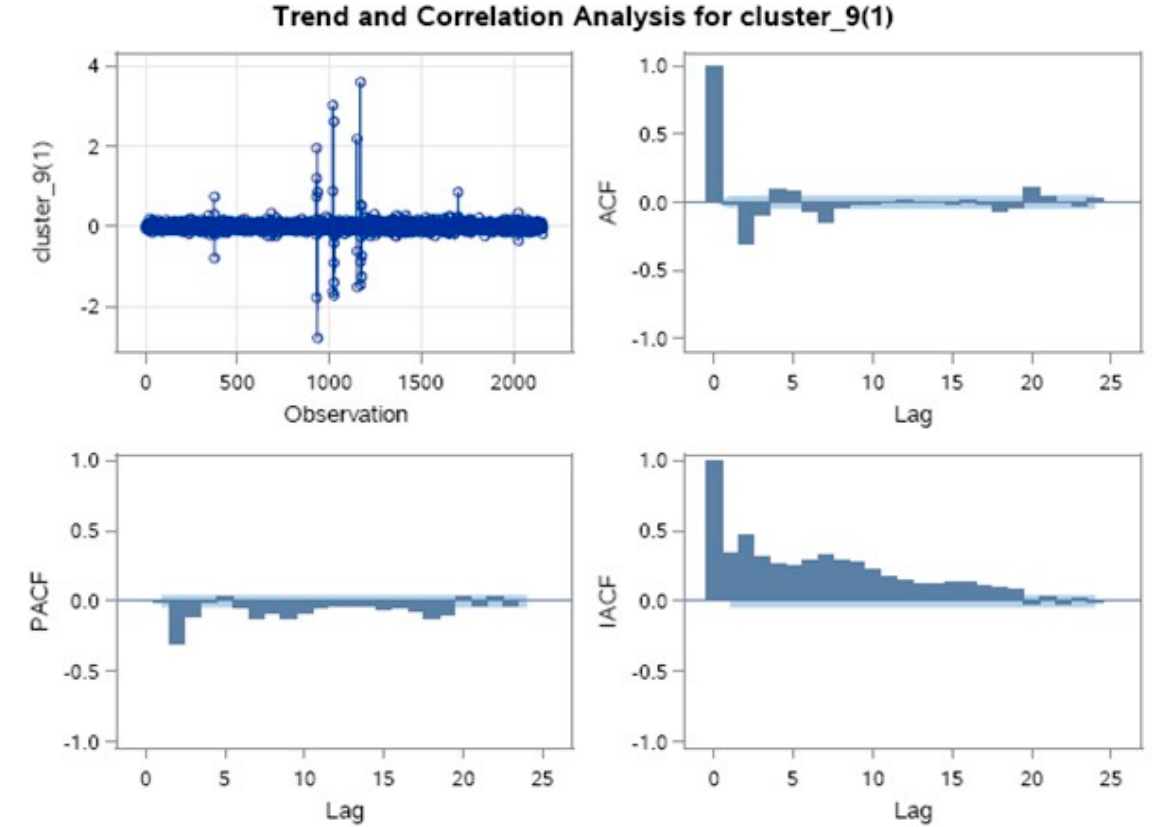
Figure 13. Trend and auto-correlation for ARIMA (1, 1, 1).